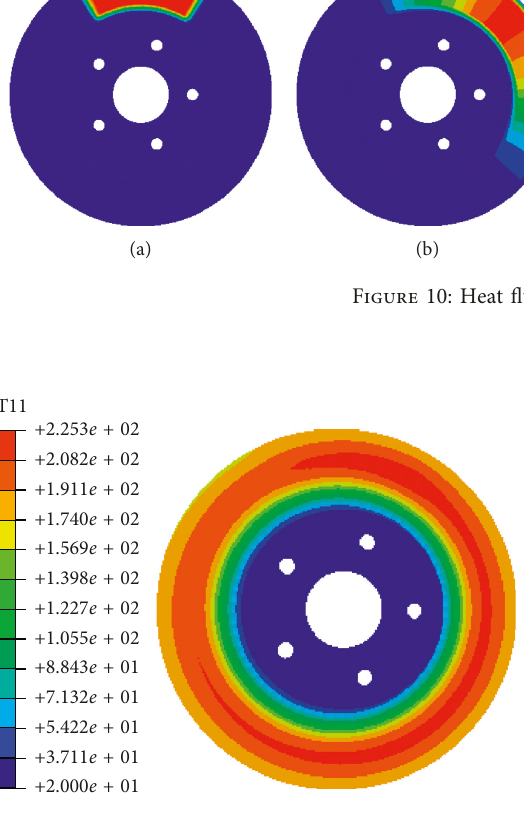
Figure 11: Distribution nephogram at the highest temperature of the brake disc.